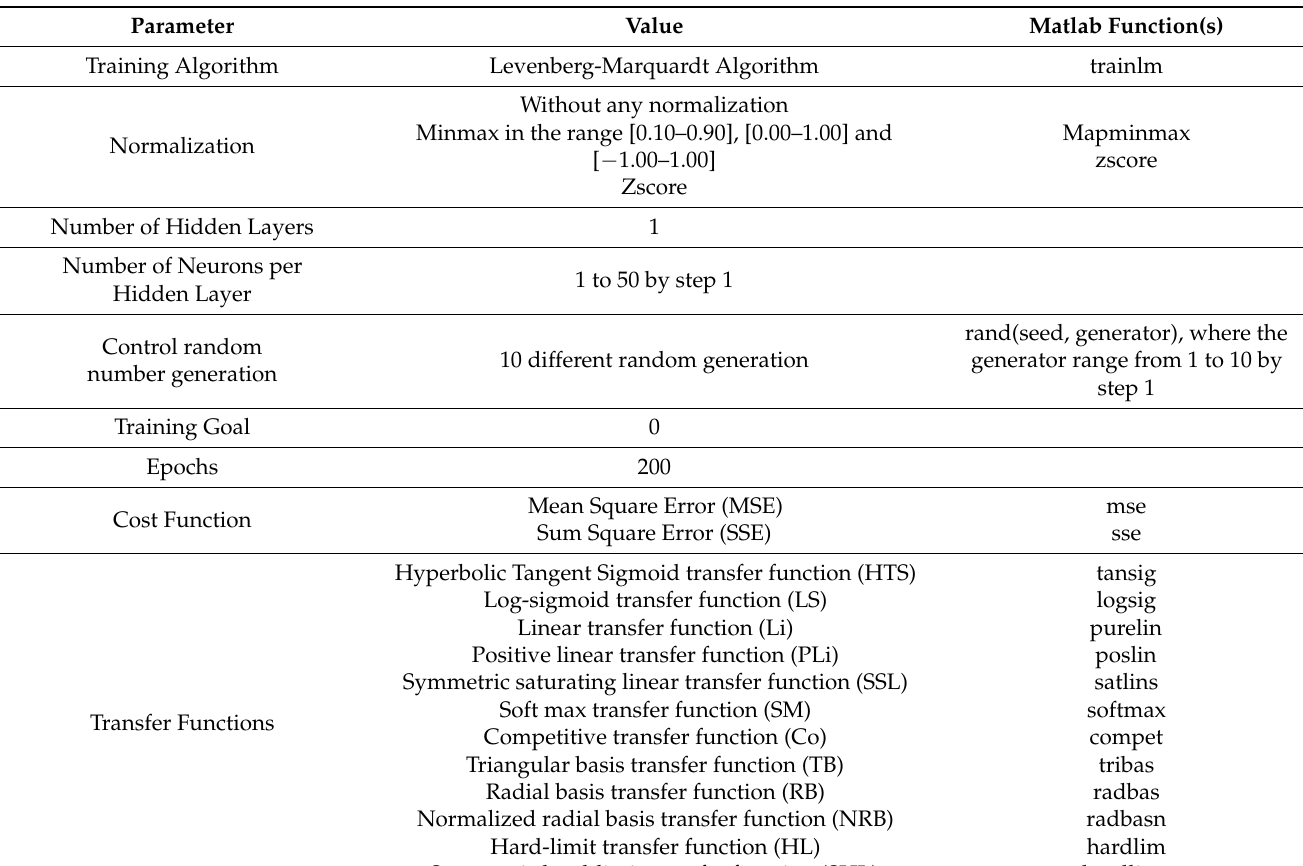
Table 5. Hyperparameters for the training and development of ANN models applied in this study. Parameter Value Matlab Function(s) Training Algorithm Levenberg-Marquardt Algorithm trainlm